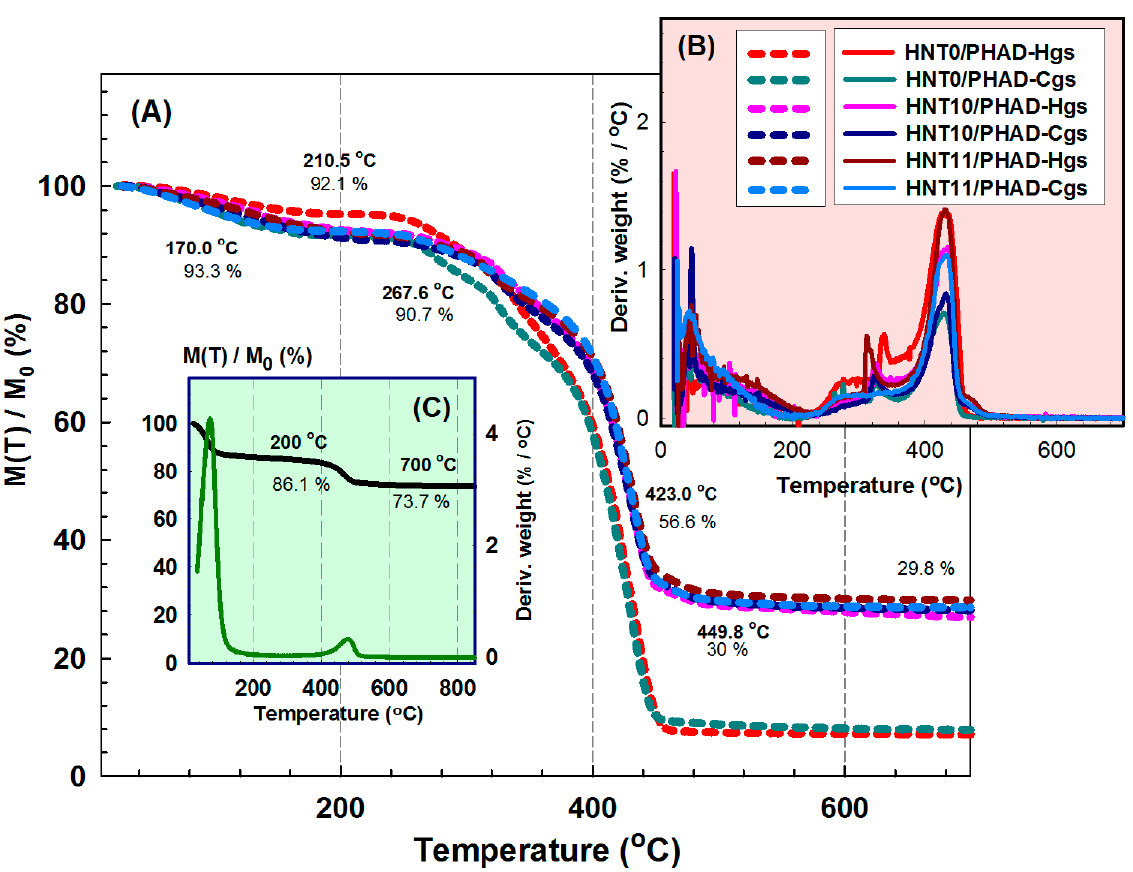
Figure 2. ( A ) M(T)/M 0 percent and ( B ) differential thermogravimetric (DTG) curves of HNT-free hydrogel and cryogel (HNT0/PHAD-Hgs and -Cgs) and ternary hybrid hydrogel and cryogel (HNT10/PHAD and HNT11/PHAD-Hgs and -Cgs) samples prepared at HNT content 2.80% and 3.20% ( w / v ). ( C ) M(T)/M 0 percent and DTG curve of pristine HNT. Table 2. Data presenting M(T)/M 0 percent and the maximum temperatures of rate decomposi- tion (Tmax) of HNT-free hydrogel and cryogel (HNT0/PHAD-Hgs and -Cgs) and ternary hybrid hydrogel and cryogel (HNT10/PHAD and HNT11/PHAD-Hgs and -Cgs) prepared at HNT content 2.80% and 3.20% ( w / v ).